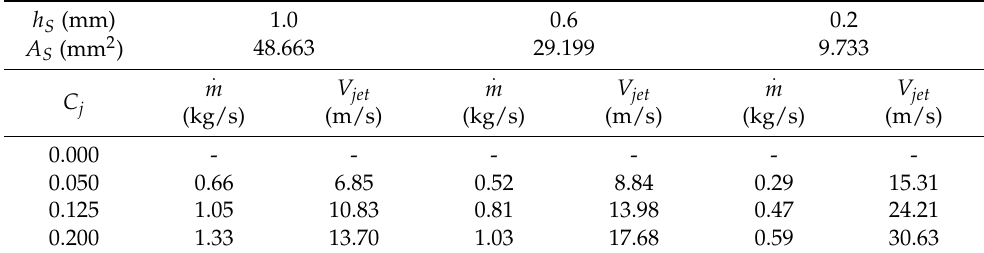
Figure 12. NACA66 (MOD, t/c = 0.24) geometry for each slit height. Table 5. Computation conditions according to the slit